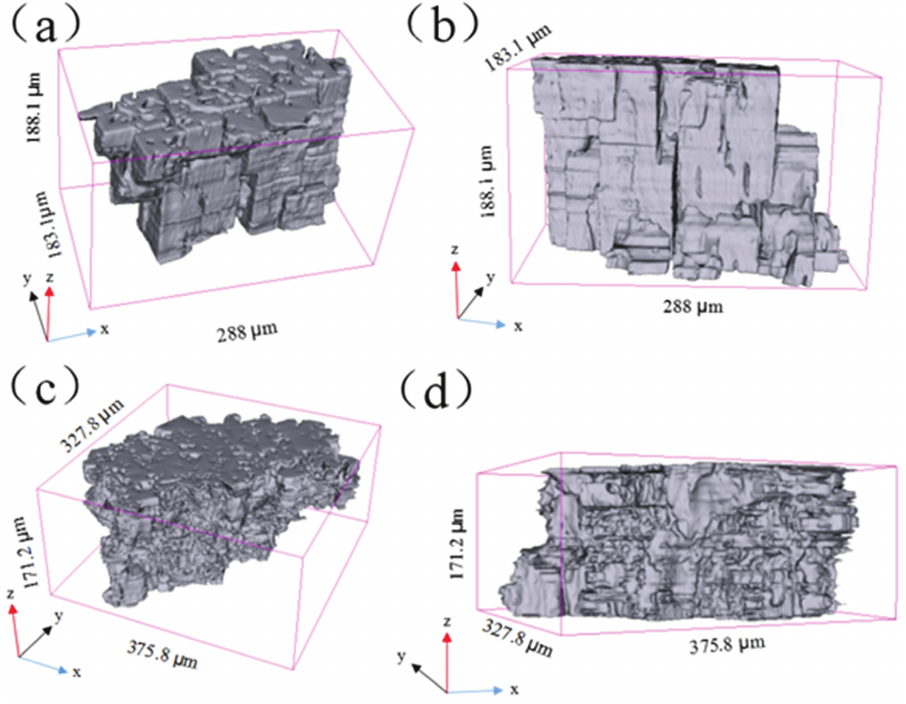
Figure 4: 3D microstructure of hematite in vanadium-titanium sinter (a), (b) and in traditional sinter (c),